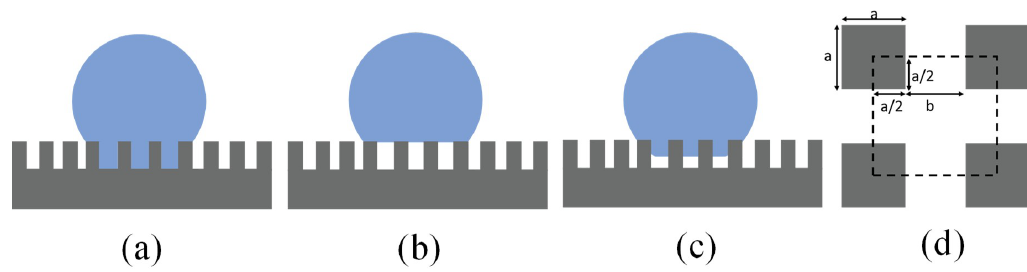
Figure 2. Schematics of different wetting states. ( a ) Wenzel state. ( b ) Cassie-Baxter state. ( c ) Transitional state between the Wenzel and Cassie-Baxter state, including the “petal effect” with simultaneously high contact angles (CA) and high Sliding angle (SA). ( d ) Top view of a typical artificial superhydrophobic surface design by creating surface roughness with pillars. The pillar height is h , the pillar breadth and width are a and the distance between adjacent pillars edges is b . The dotted square shows a periodic structure for calculation with a quarter of pillar surface counted at each corner.